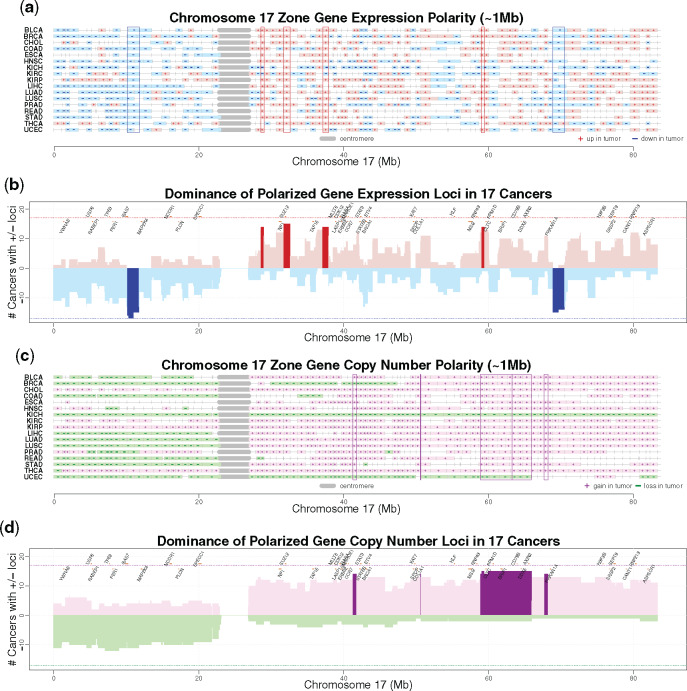
Maps of significant polarization in regulation and somatic copy number alteration (SCNA) along chromosome 17 across cancer types. (a) 17p is dominated by negative (-, blue) polarity in regulation, but 17q is more dominated by positive polarity (+, red) in regulation. Six loci surrounded by boxes are conserved in zone regulation polarity across cancer types. (b) Numbers of cancer types either positively (red) or negatively (blue) polarized in regulation along chromosomal loci. Loci are defined by intersections among zones. Dark red/blue bars indicate 14 (80%) or more of cancer types being identically polarized at a locus. Known cancer genes are marked along chromosomes. (c) Statistically significant zone polarization in SCNA along the chromosome across cancer types, corresponding to amplification (+, purple) and deletion (-, green), respectively. (d) Numbers of cancer types either positively (purple) or negatively (green) polarized in SCNA at loci along the chromosome. Dark purple/green bars indicate over 80% of cancer types are positively/negatively polarized in SCNA at a locus